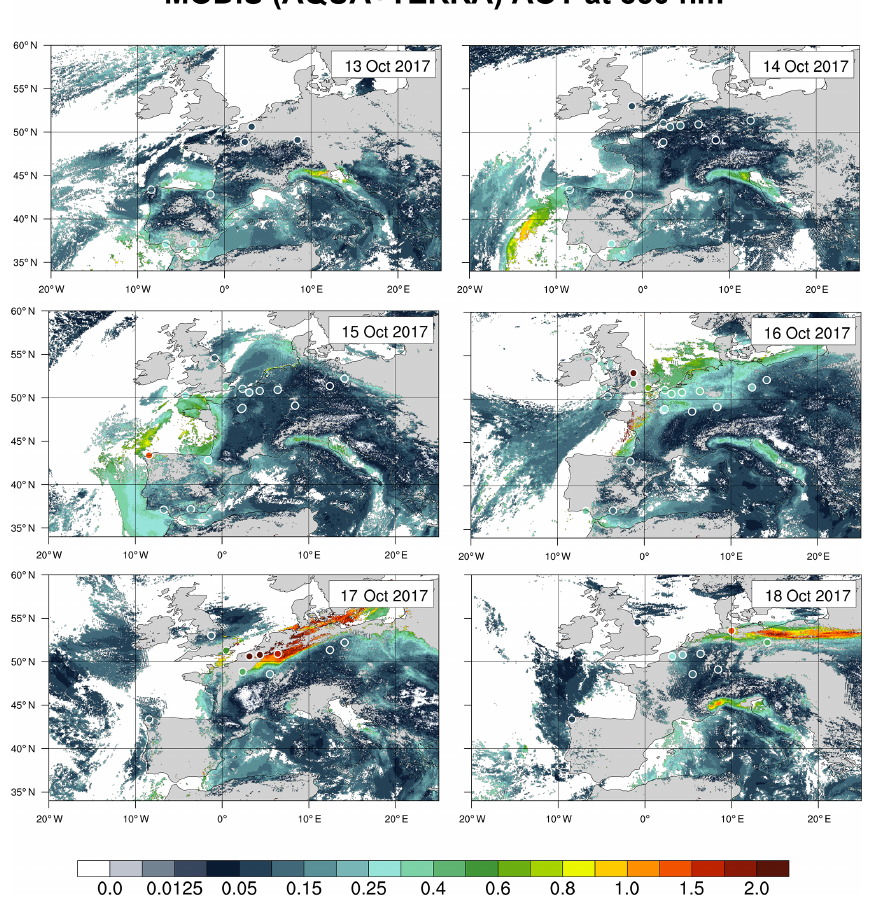
Figure 6. Daily snapshots of AODs at 550nm from the MODIS instrument combining granules from the AQUA and TERRA platforms. Circles represents the AODs at 500nm from the AERONET ground sites collocated in time to match AQUA and TERRA overpass